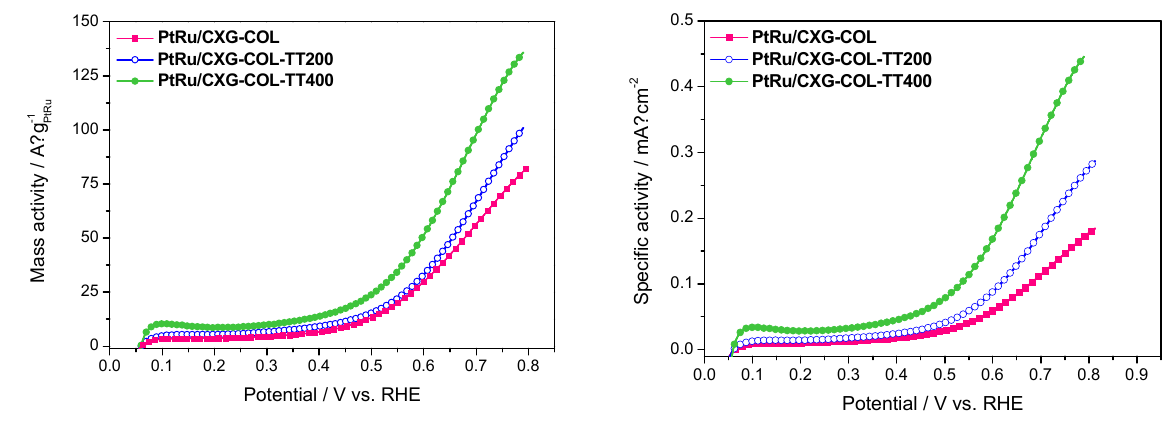
OH + 0.5 M H SO 3 2 4